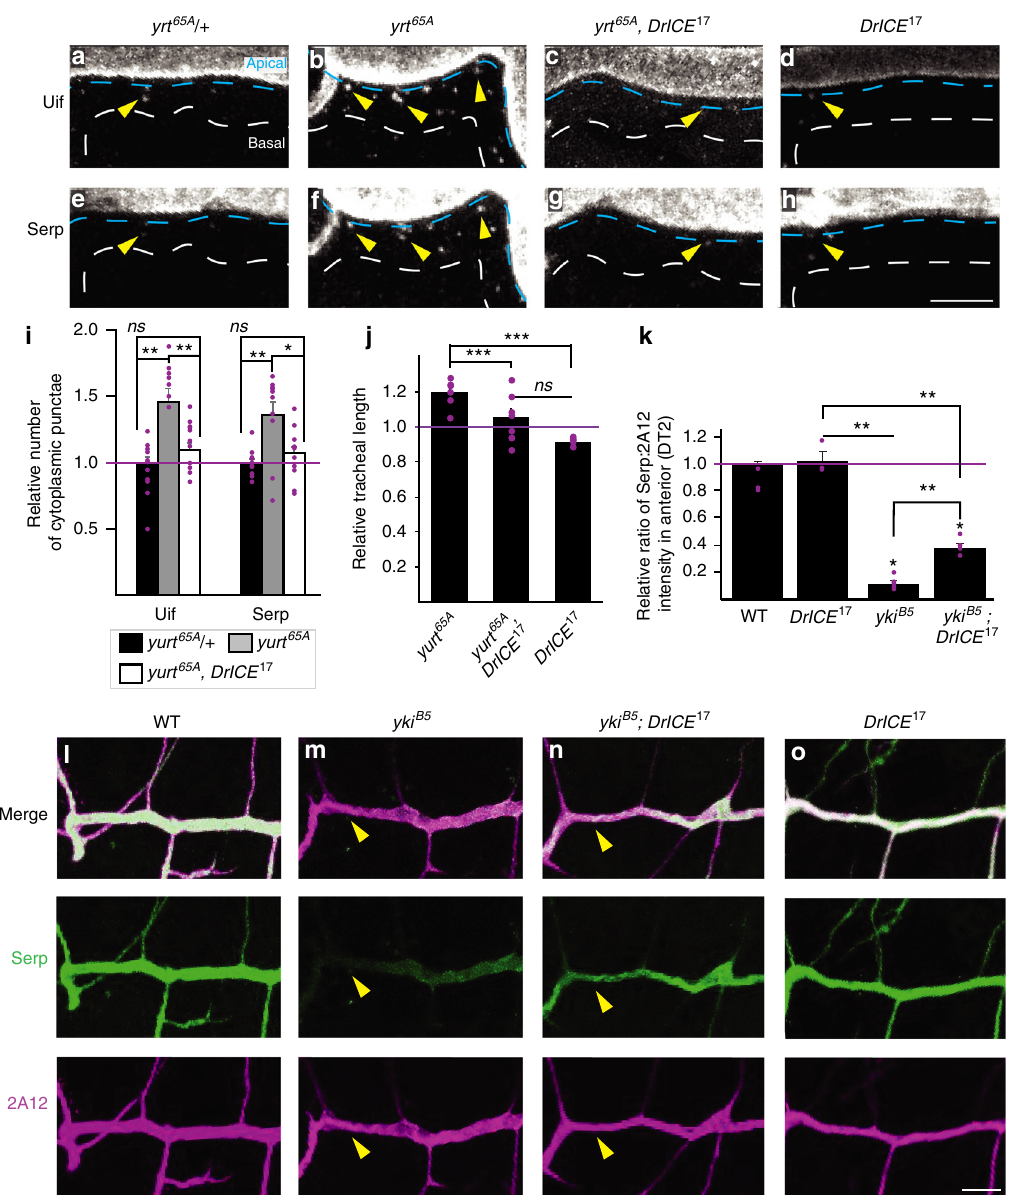
Fig. 4 DrICE is required for traf fi cking of tracheal size determinants Serpentine and Uif. a – h Mutation of the basolateral polarity protein Yurt ( yrt 65A ) causes abnormal intracellular accumulation of the tracheal size determinants Uif ( b , arrowhead) and Serp ( f , arrowhead), an effect that is suppressed by DrICE 17 ( c , g ). White dashed lines outline basal cell surface; blue dashed lines outline apical surface. Scale bar a – h in h , 5 μ m. i Relative number of cytoplasmic punctae quanti fi ed, where the number of punctae in each of two ROIs in a maximum projection of yrt 65A ( N = 5 embryos), yrt 65A / + ( N = 5 embryos), and yrt 65A , DrICE 17 ( N = 6 embryos) was counted, then divided by the area of the given ROI. Resulting number of puncta per area is reported relative to yrt 65A / + . j The DrICE 17 mutation suppresses tracheal overelongation caused by a mutation in the basolateral polarity gene yrt . Quanti fi cation of tracheal DT length at stage 16 for yurt 65A ( N = 6) and yurt 65A , DrICE 17 ( N = 7) and DrICE 17 ( N = 5) mutants reveals that yurt 65A , DrICE 17 double mutants are shorter than yurt 65A mutants. Tracheal lengths normalized to body length and reported relative to WT ( w 1118 ). For all graphs, each data point is represented as a point. k – o Mutation of the Hippo Network component Yki ( yki B5 ) reduces the levels of Serp (green) in the tracheal anterior relative to the lumenal chitin binding protein Gasp, marked by staining with the monoclonal antibody 2A12 (arrowhead, m ). This reduction is suppressed by DrICE 17 ( n ). k Quanti fi cation of the mean intensity of Serp divided by the mean intensity of 2A12 in a maximum projection of N = 4 embryos for WT ( w 1118 ), N = 4 embryos for yki B5 ; DrICE 17 , N = 7 embryos for yki B5 , N = 3 embryos for DrICE 17 ; Numbers reported as relative to w 1118 . Scale bar l – o in o , 12.5 μ m. For all graphs, error bars represent S. E.M. and each data point is represented as a point. Source data are provided as a source data fi le. p < 0.05; ** p < 0.005; *** p < 0.0005 Student ’ s t